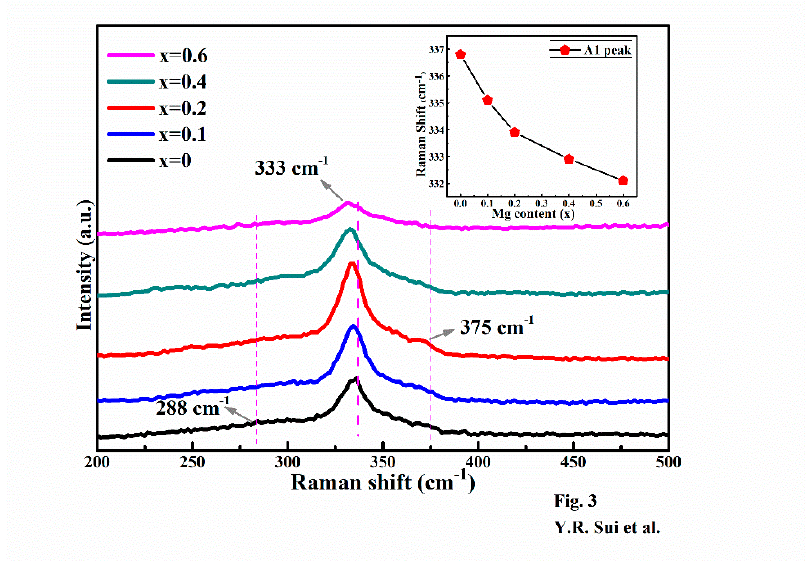
Figure 3. Raman spectra of Cu 2 Mg x Zn 1 − x SnS 4 (0 ≤ x ≤ 0.6) thin films. Inset: The main Raman peaks of A 1 mode as a function of the Mg content.